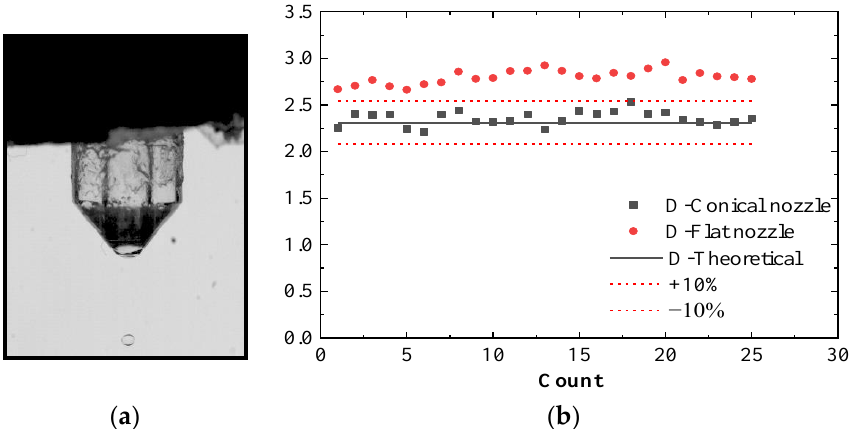
Figure 2. Image of ( a ) conical nozzle and ( b ) comparison of droplet diameter distributions resulting from the flat and conical nozzles .